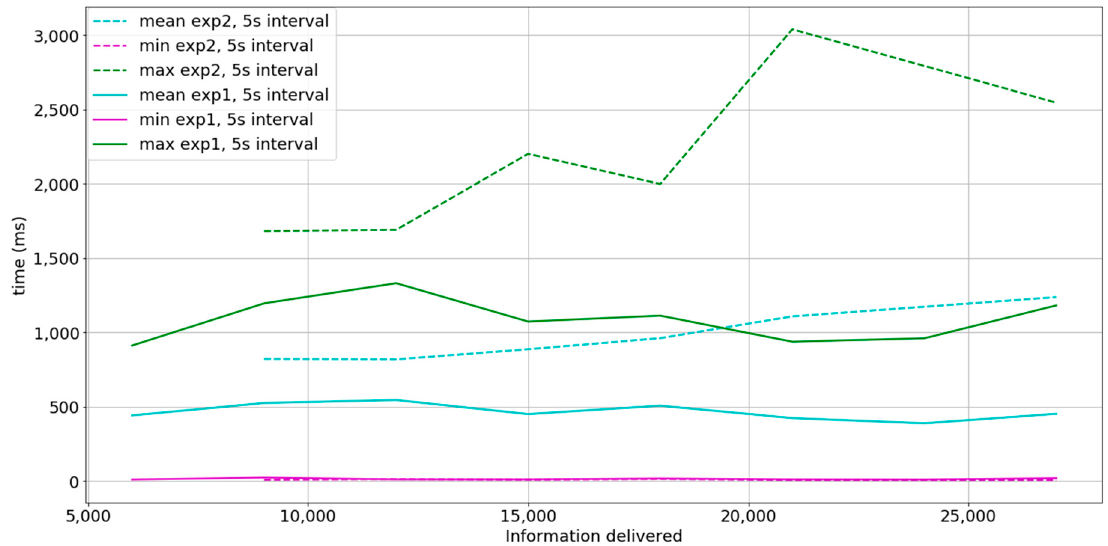
Figure 11. Comparison between experiment 1 and experiment 2 at a 5-s interval between bursts. x -axis equals to the total information delivered and refers to both individual messages at experiment 1 and aggregated messages at experiment 2. Dashed lines represent measurements in experiment 2 at a 5-s interval between bursts. Continuous lines represent measurements in experiment 1 at a 5-s interval. Cyan lines indicate the mean timedelta, magenta lines indicate the minimum timedelta, and green lines represent the maximum timedelta.